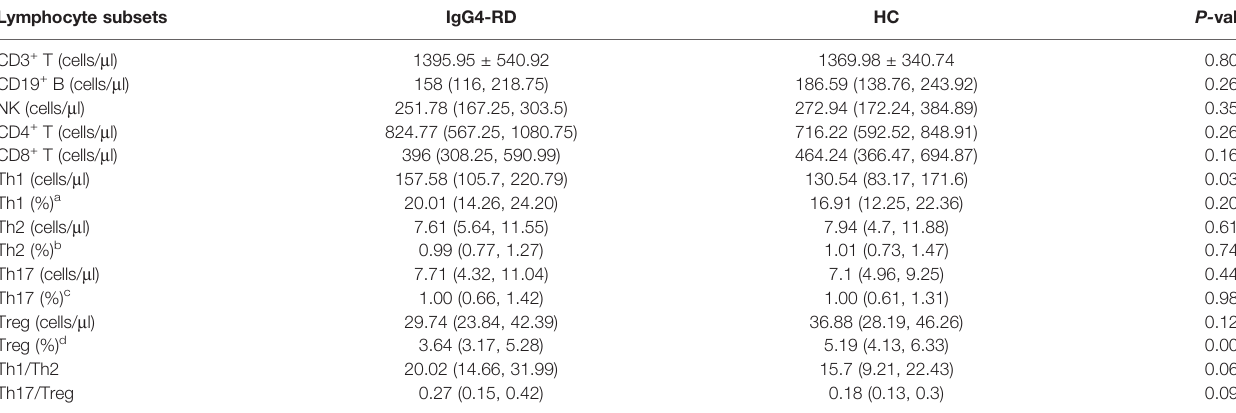
TABLE 5 | Lymphocyte subgroups and CD4 + T cell subsets in patients with IgG4-RD. Lymphocyte